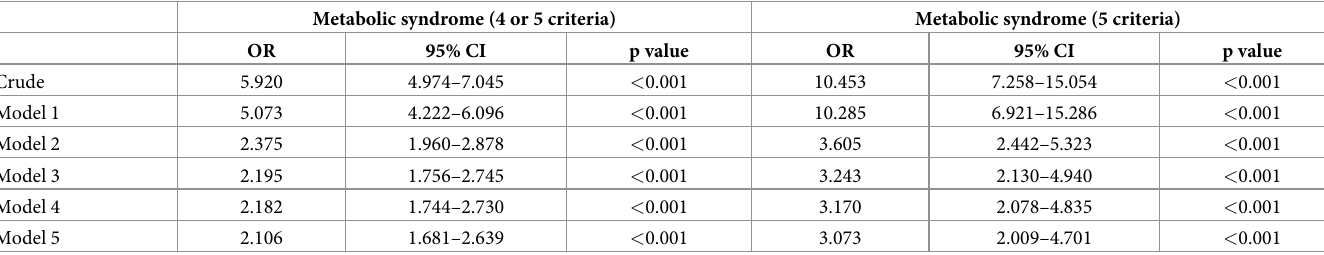
Table 4. Association between severe metabolic syndrome (4 or 5 criteria) and